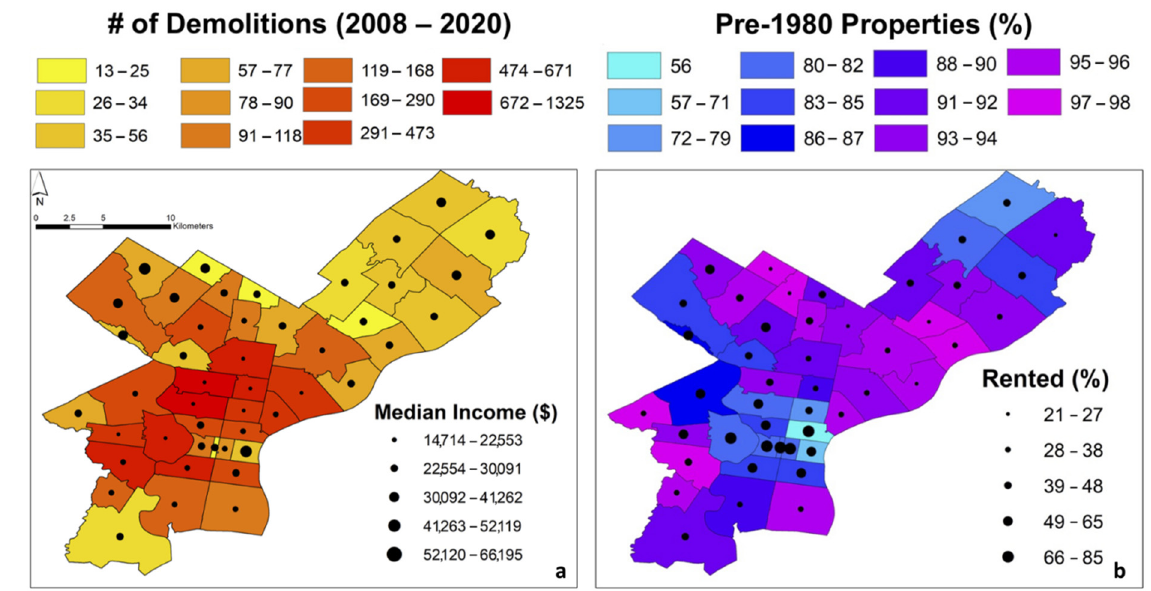
Figure 7. Bivariate plots demonstrating % EBLL compared with % children in poverty (dots) ( a ); % EBLL compared with % owner-occupied properties (dots) ( b ); % EBLL compared with the number of demolitions (dots) ( c ); and % EBLL compared with % Black population (dots) ( d ).